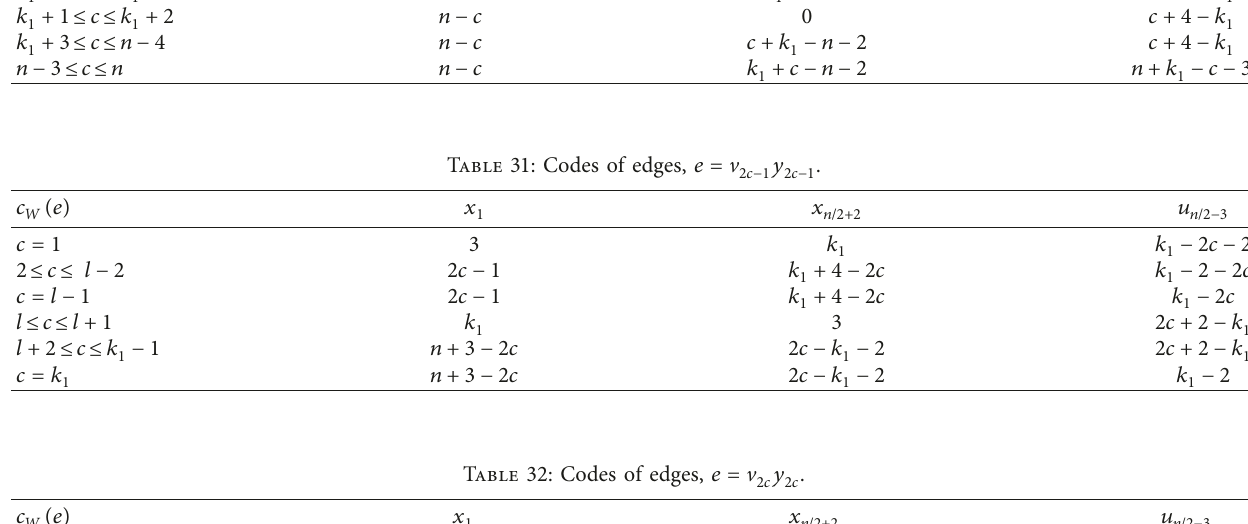
Table 32: Codes of edges, e � v